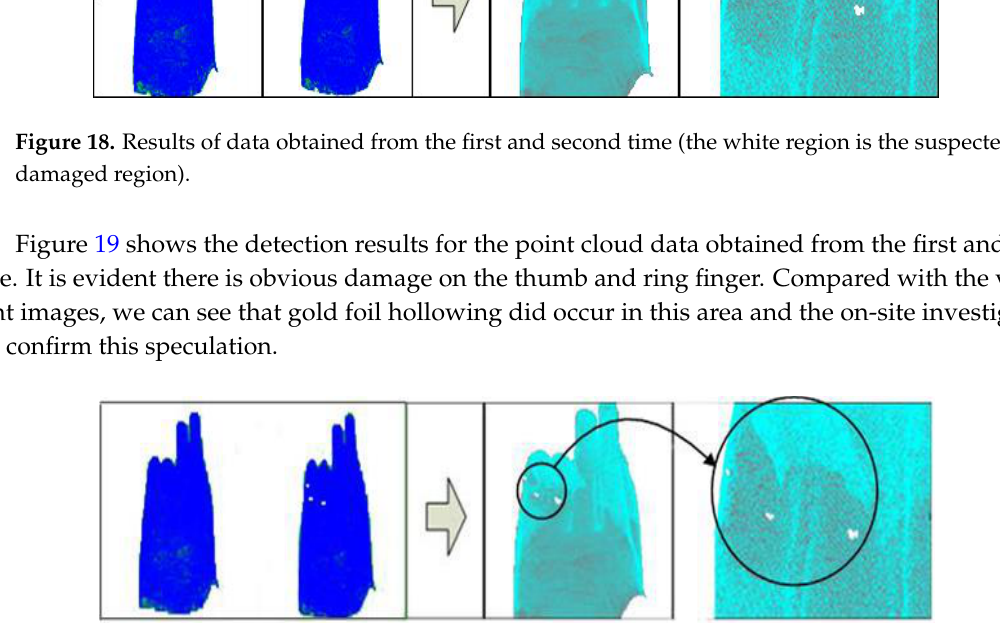
Figure 19. Results of data obtained from the first and third time (the white region is the suspected damaged region).